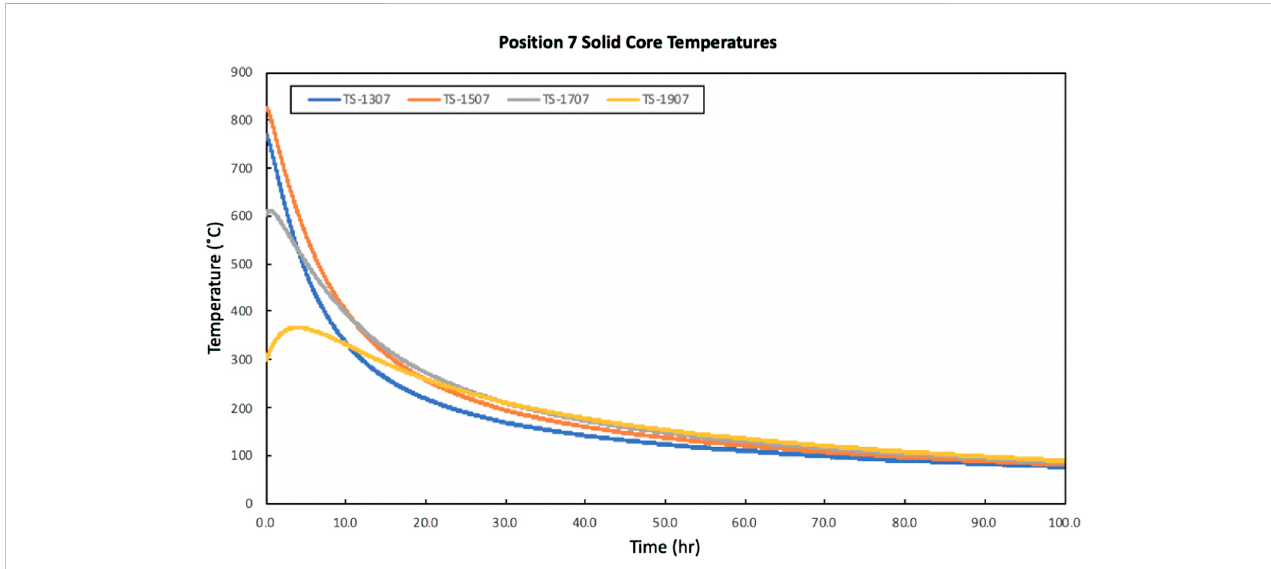
FIGURE 12 Core ceramic temperatures during PG-33 test.